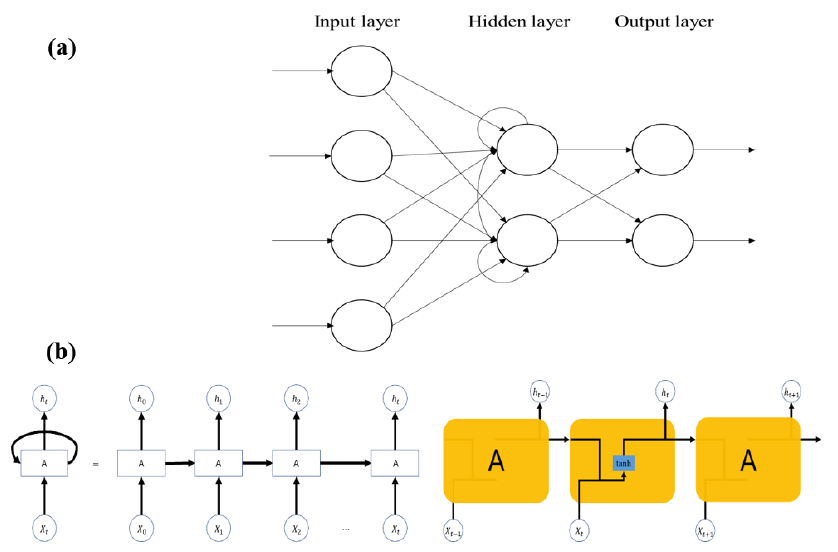
Fig. 4. The structure of RNN